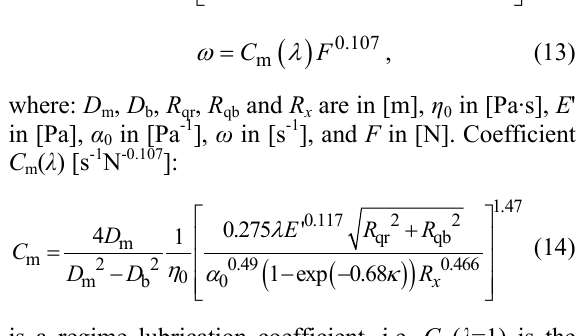
Figure 3. Profile lines profile arithmetic mean deviation. In addition to the profile arithmetic mean deviation (arithmetic